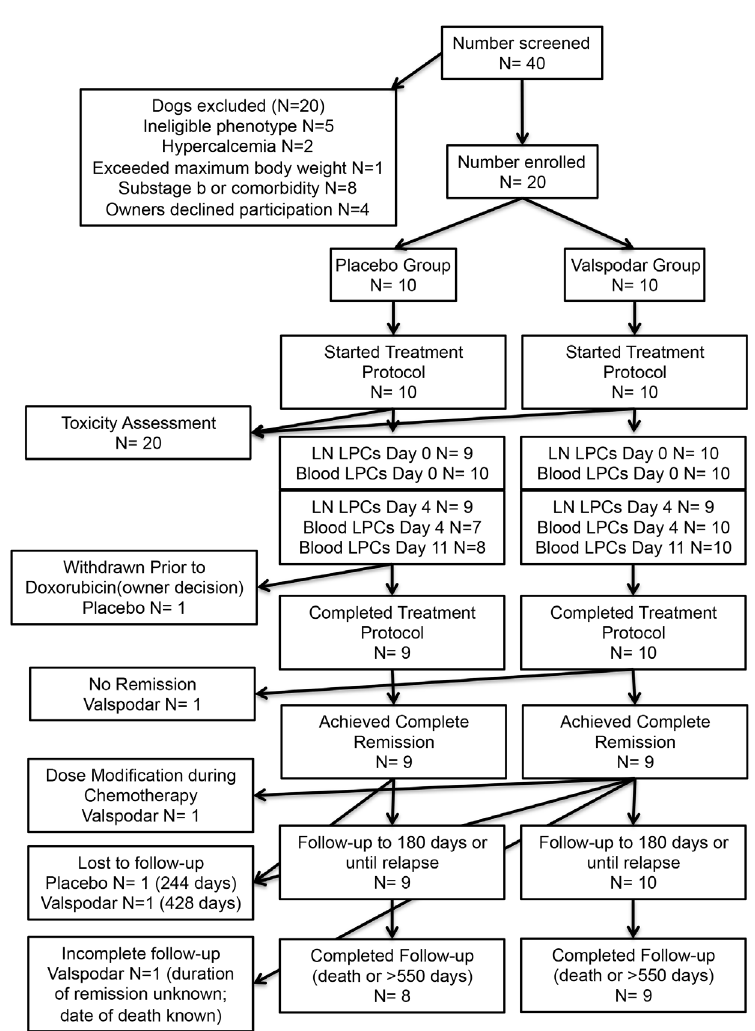
Figure 1. Enrollment, exclusions, and assessments. Flow chart with details of dogs enrolled in the study and exclusions from each of the measured